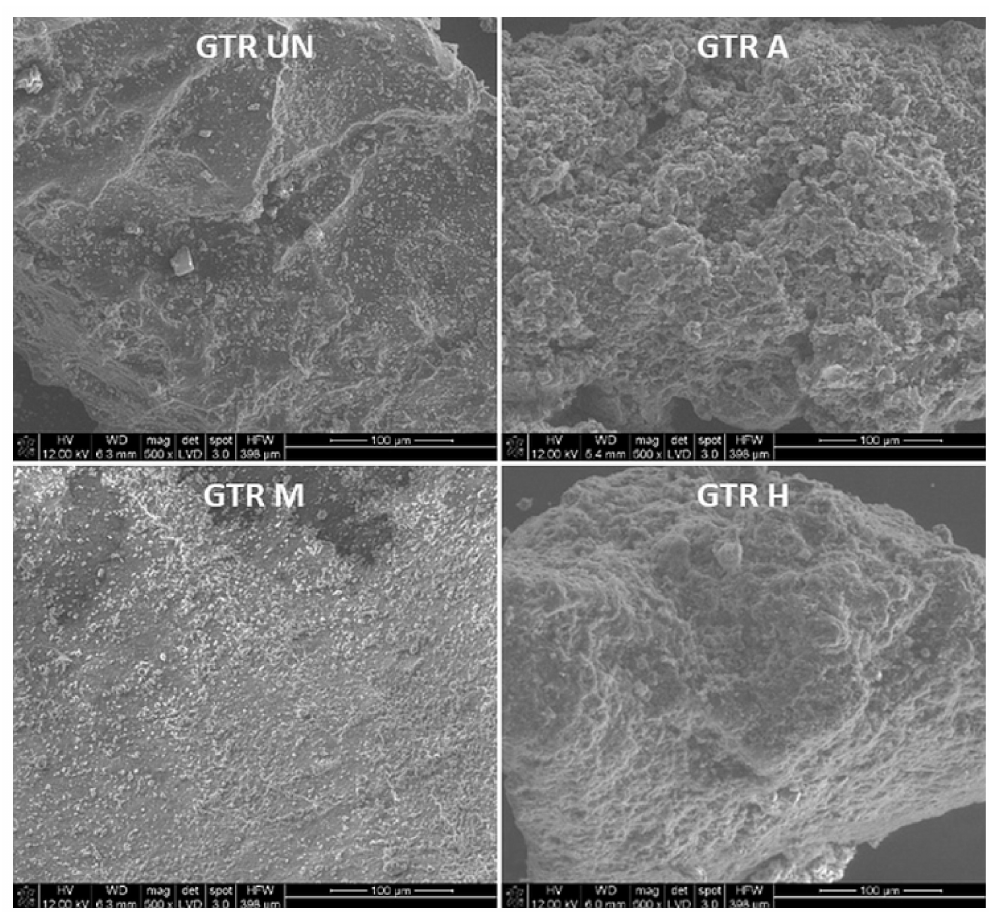
Figure 4. SEM picture of an untreated (GTR UN), subjected to activation (GTR A), modification (GTR M), or hybrid treatment (GTR H) GTR particles’